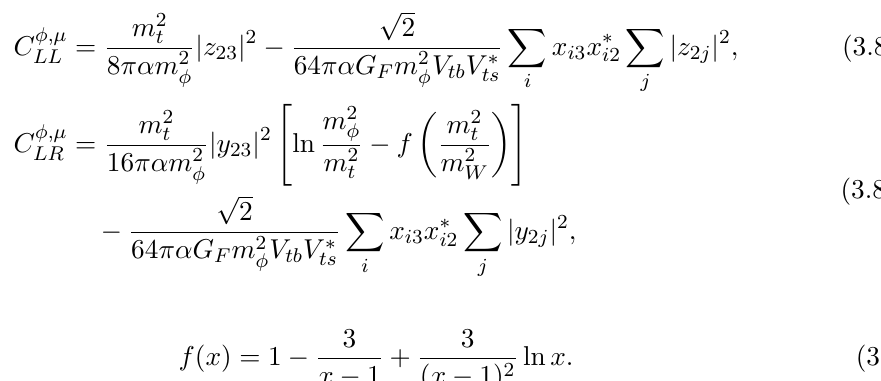
at the one-loop level with coe(cid:14)cients